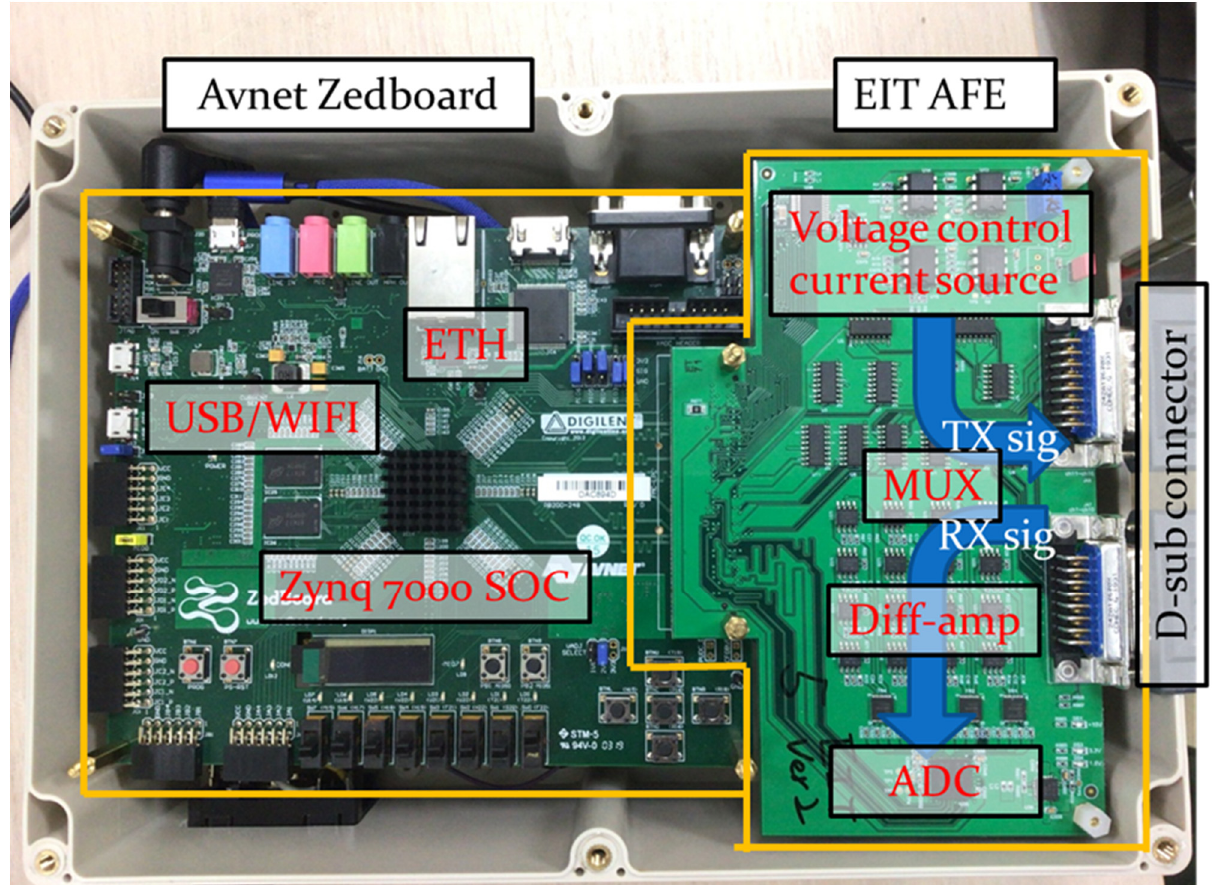
Figure 1. Our proposed portable electrical impedance tomography (EIT) system.